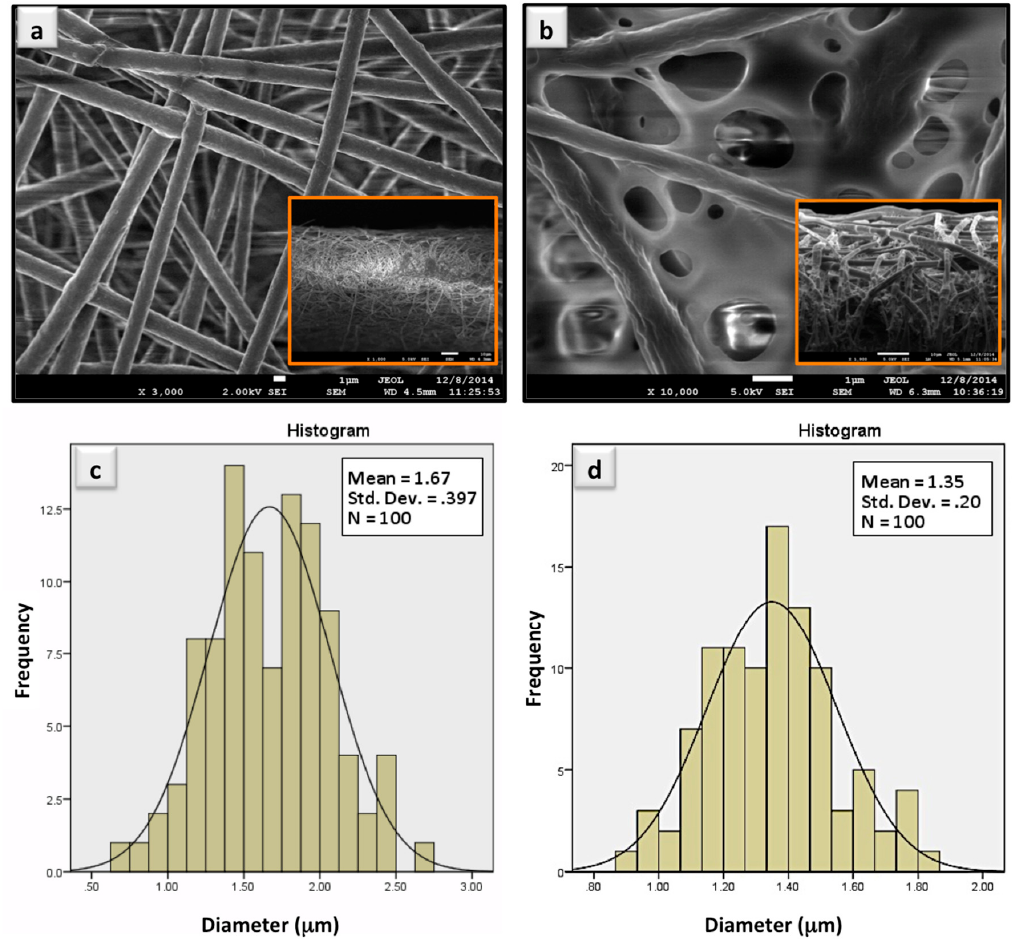
Figure 1. SEM and diameter range analyses of: ( a , c ) uncoated; and ( b , d ) polymer coated PHB fibers, respectively. Inserts are cross section SEM images of the samples ( a , b ).